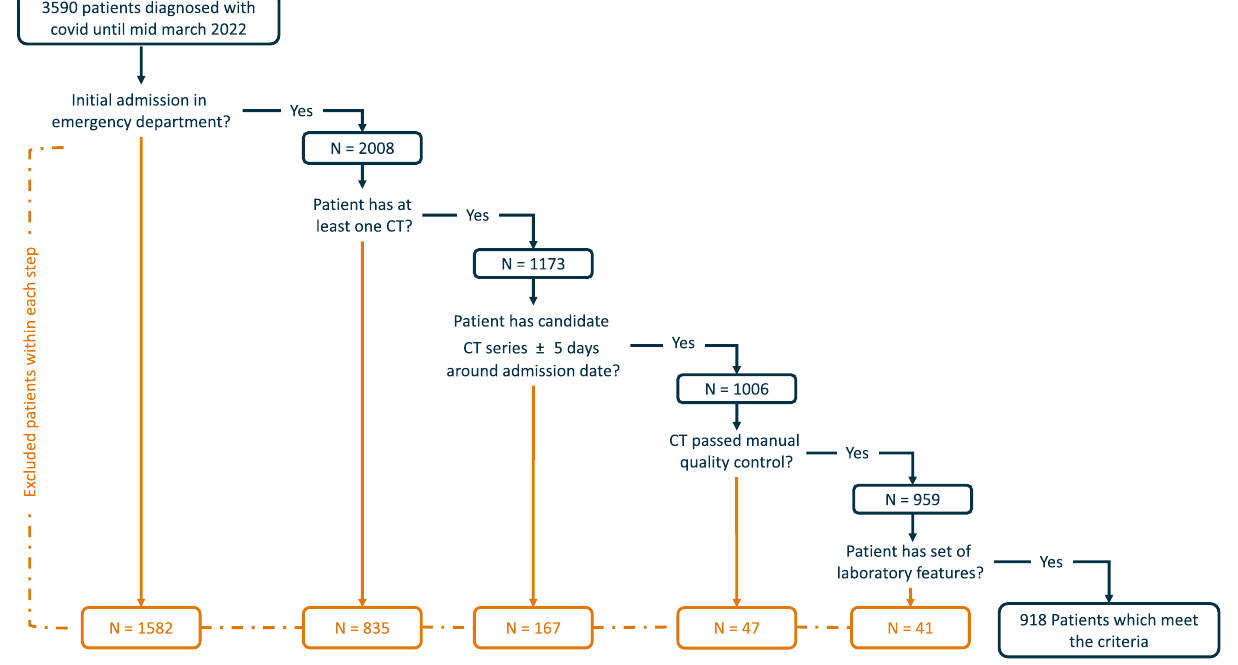
Figure 1. The data flow based on all identified and collected SARS-CoV-2 patients until March 2022. Overall, 3590 unique Patients were identified, but only 918 were used for further univariate and multivariate analysis as not all patients identified had a valid CT scan and/or the defined laboratory features